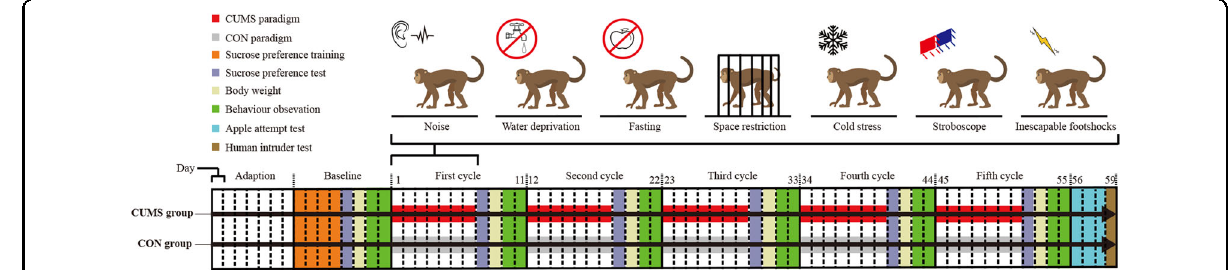
Fig. 1 Overview of the experiment protocol. CUMS paradigm (red) and CON paradigm (gray) were conducted to each group,